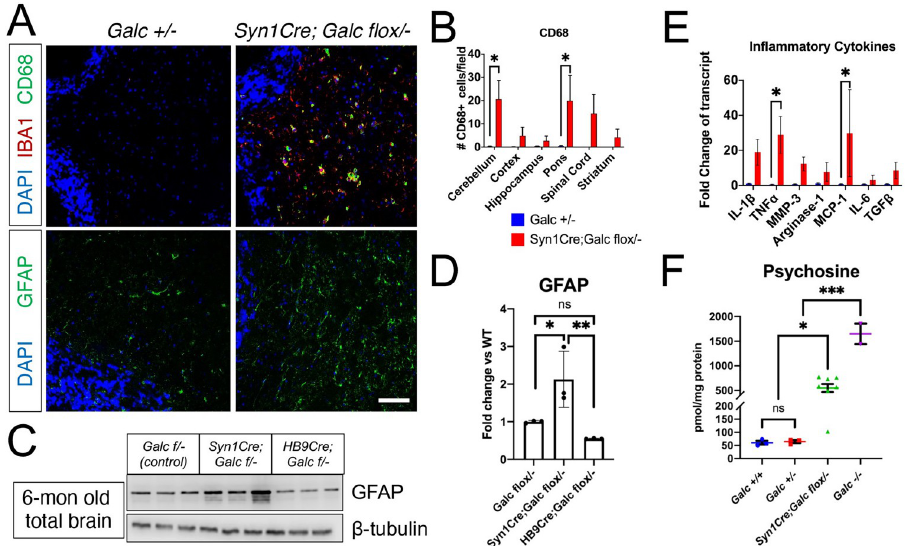
Fig 6. Neuron-specific Galc deleted mice have inflammatory gliosis with the accumulation of psychosine. ( A ) Immunohistochemistry on cryo-sections of cerebellar white matter shows activated microgliosis (Iba1 and CD68) and astrocytosis (GFAP), in the brain of Syn1Cre; Galc flox/− . Scale bar = 100 μ m. DAPI is blue-colored. ( B ) Quantitative analyses shows that a phagocytic inflammatory marker CD68 was significantly higher in the cerebellum and pons of Syn1Cre; Galc flox/− , compared to control ( Galc + /− ) at 6 months old. N = 5. ( C ) Western blot analysis reveals a dramatic increase in the marker of astrocytosis (GFAP) in the brain of Syn1Cre; Galc flox/− . MN-specific HB9Cre; Galc flox/− has no increase of GFAP level in the brain. ( D ) Quantification of the protein band density shows an increase of GFAP in the Syn1Cre; Galc flox/− , but not in HB9Cre; Galc flox/− , compared to control ( Galc + /− ). ( E ) Quantitative reverse-transcriptase PCR analyses of inflammatory cytokines shows that there was a significant increase in TNF α and MCP-1 and moderate up-regulation of IL-1b, MMP-3, Arginase-1, IL-6 and TGF β . N = 3 for Galc +/− , N = 4 for Syn1Cre; Galc flox/− , with 3 technical replicates. Data are presented as mean values ± SEM; � P < 0.05, �� P < 0.01, ��� P < 0.001, and ns, not significant. ( F ) Psychosine was measured in the cervical spinal cords of 6-month-old each substrain, except Galc −/− which were moribund P37-38. Psychosine level is significantly increased in the Syn1Cre; Galc flox/− compared to both Galc +/+ and Galc + /− , although its level is only a third of the full KO Galc −/− . N = 7 for Syn1Cre; Galc flox/− and N = 3 for others. Data are presented as mean values ± SEM; � P < 0.05, �� P < 0.01, ��� P < 0.001, and ns, not significant. The underlying data for B and D – F can be found in S1 Data. GALC, galactosylceramidase; KO, knockout; IL, interleukin; MN, motor neuron; TGF β , transforming growth factor beta; TNF α , tumor necrosis factor